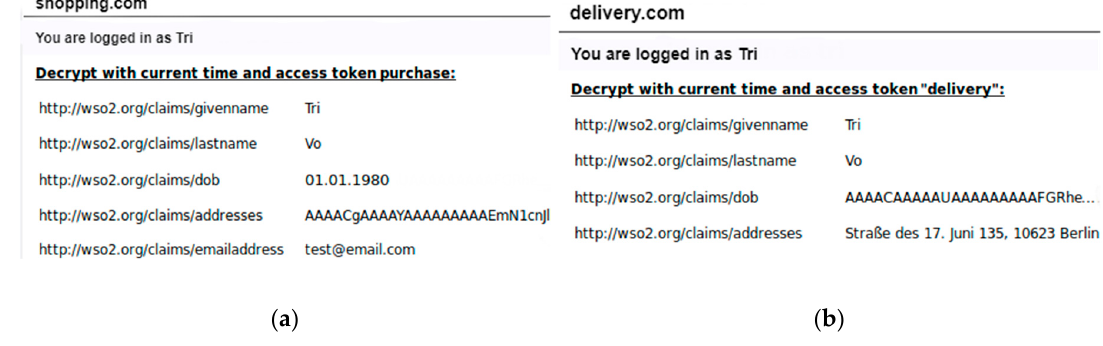
Figure 16. ( a ) The shopping service; ( b ) The delivery service.